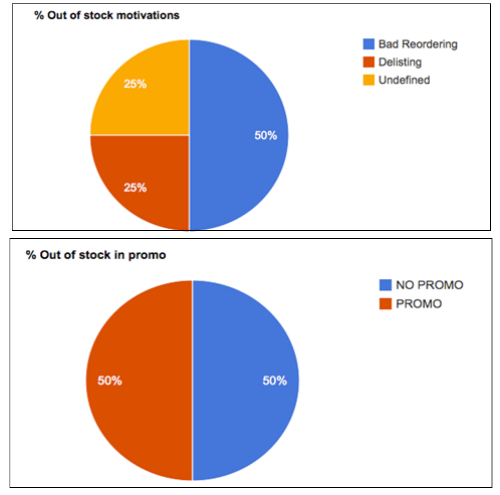
Figure 13. Pie graphs discriminating motivations and